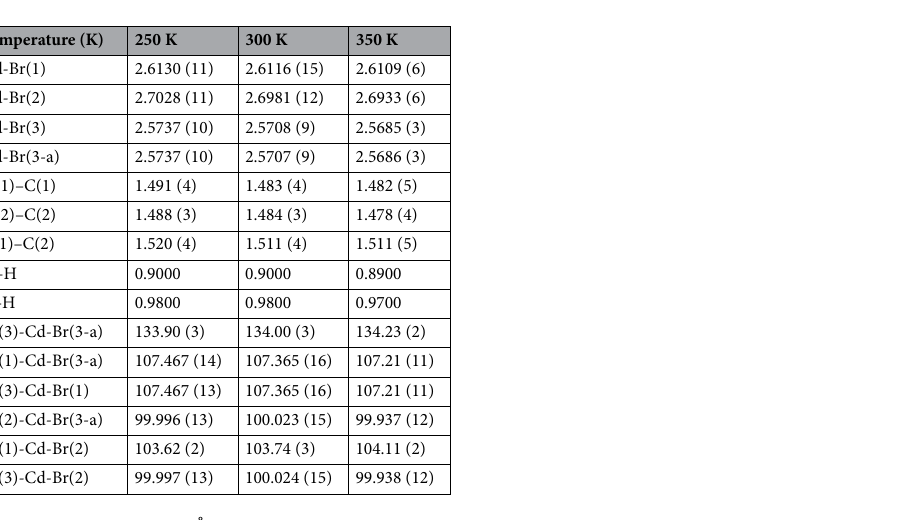
Table 2. Bond lengths (Å) and bond-angles (°) for [NH 3 (CH 2 ) 2 NH 3 ] 2 CdBr 4 ·2Br at 250 K, 300 K, and 350